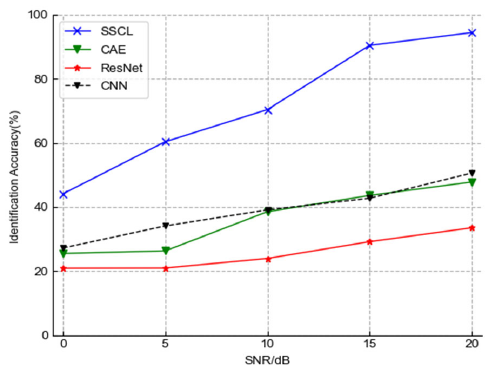
Figure 5. Identification accuracy under different models.